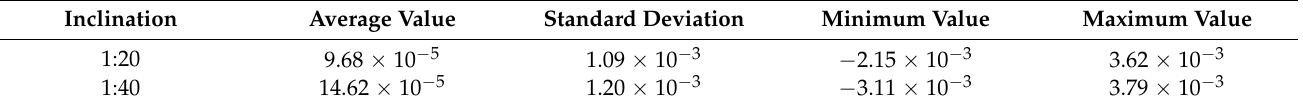
Table 2. The statistical values of the lateral displacement (in m) of the wheelset at various rail inclinations.